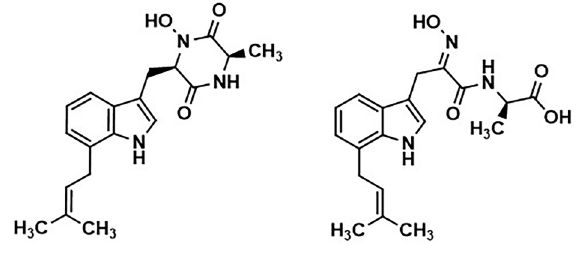
Figure 1. Chemical structures of 14-hydroxyterezine D and terezine